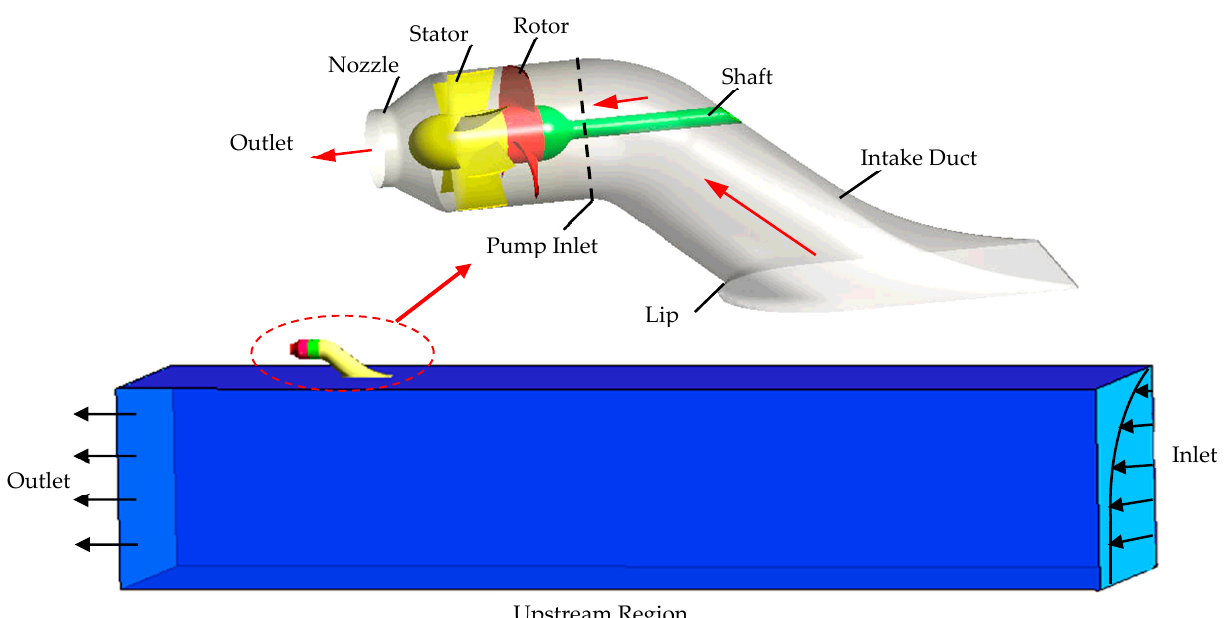
Figure 2. Configuration of a waterjet pump under nonuniform suction.